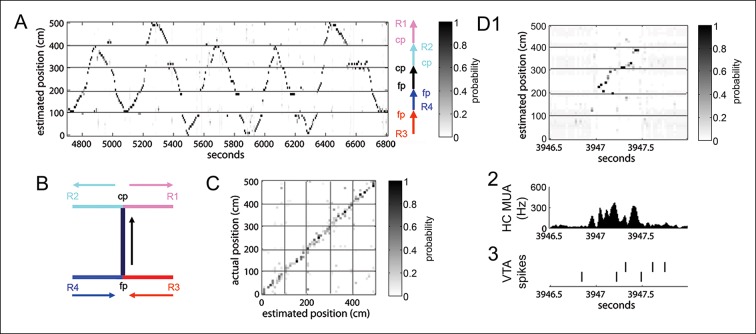
Position reconstruction using clusterless hippocampal decoding.(A) Bayesian reconstruction of run behavior on the spatial working memory task (500 ms time bins). The track has been linearized. (B) Decomposition of the track into segments for linearization. Maze segments were apposed in the direction of run in the choice direction: from force reward sites (R3, R4) to force point (fp) to choice point (cp) to choice reward sites (R1, R2). (C) Confusion plot for this recording session, using alternating 1 s epochs for training and testing the reconstruction algorithm. (D1) Bayesian reconstruction of a SPW-R event reveals spatial sequence reactivation (25 ms time bins). (D2) The associated hippocampal multiunit activity. (D3) The action potentials of two simultaneously recorded reward responsive VTA units.